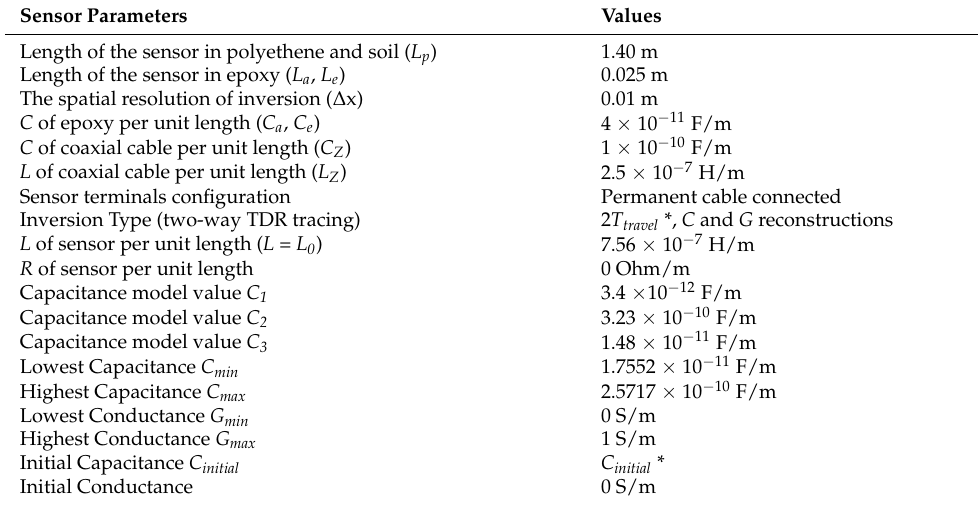
Table 3. The parameters specification of the FRC sensor in the fast TDR inversion analysis. Sensor